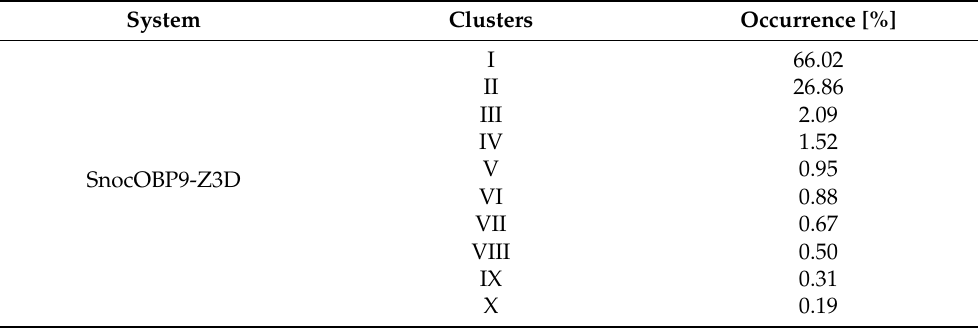
Table 4. Cluster analysis of the SnocOBP9-Z3D complex based on the trajectory of MD simulations. System